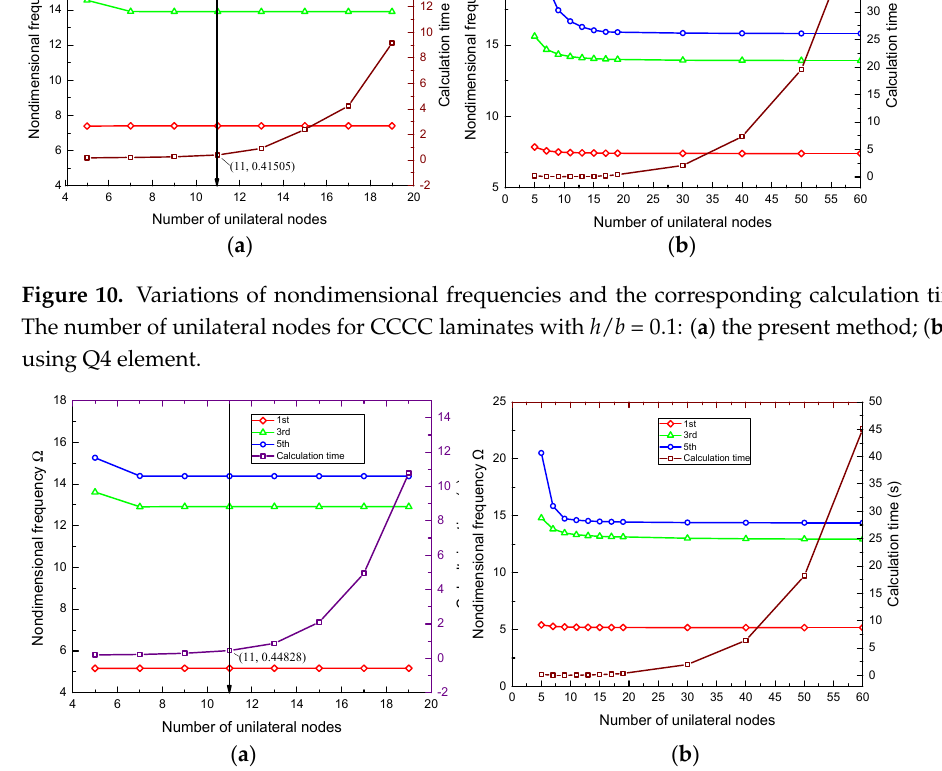
Figure 11. Variations of nondimensional frequencies and the corresponding calculation time vs. the number of unilateral nodes for SSSS laminates with h / b =0.1: ( a ) the present method; ( b ) FEM using Q4 element.